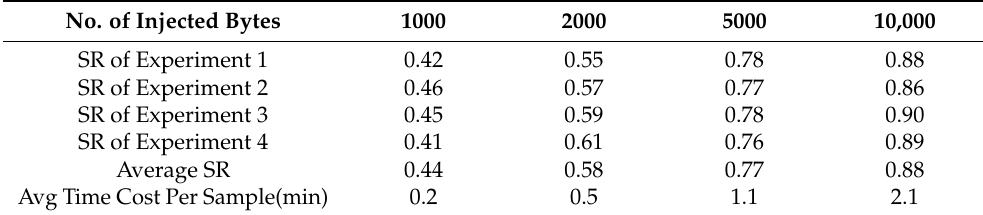
Table 2. SR of the proposed method adopting the mid-file strategy.